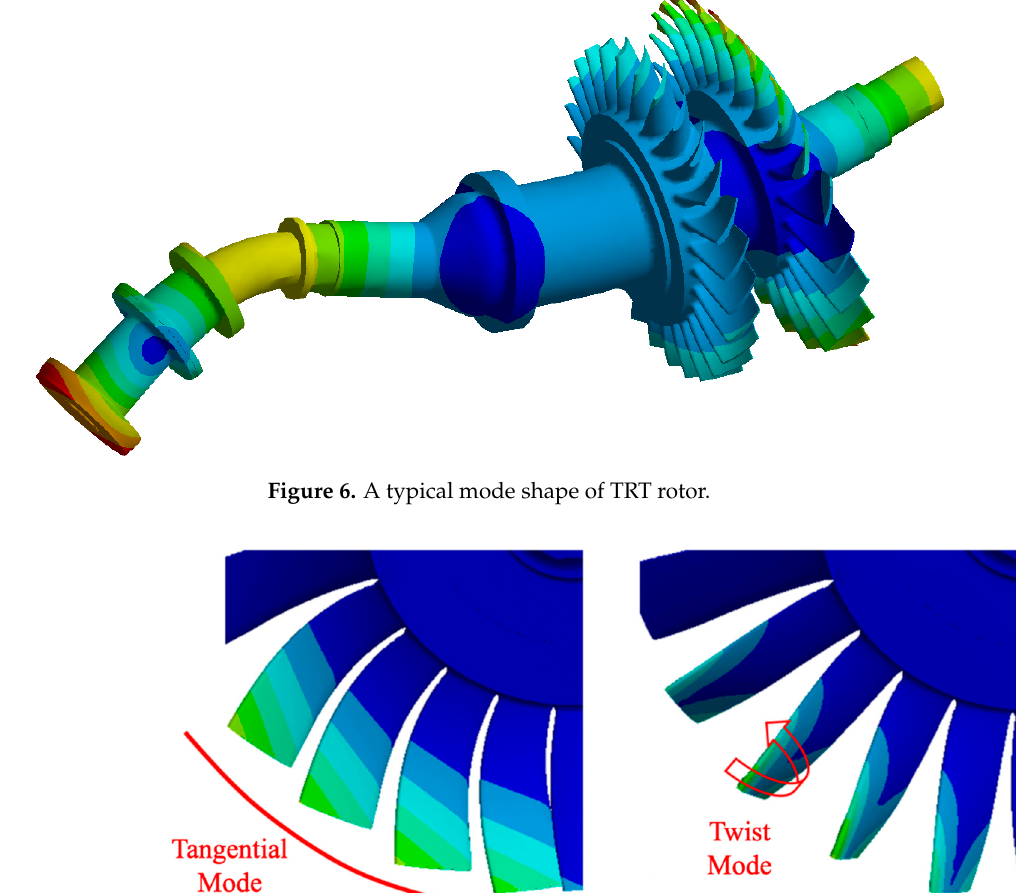
Figure 7. A typical mode shape of TRT blades.